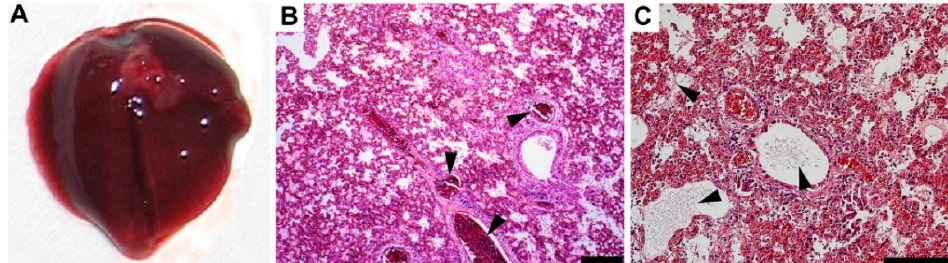
Figure 7. Postmortem examination (5 dpi) of a dead mouse infected with a high dose of the clinical isolate. ( A ) Gross pathology of lungs dissected from the dead mouse. Note the diffuse dark red coloration of parenchyma. ( B ) Condition showing hyperemia of the parenchyma with dilated vessels filled with blood (black arrowheads). ( C ) Diffuse alveolar damage with intra-alveolar fibrin deposits (black arrowheads). H&E staining, scale bars: 200 µ